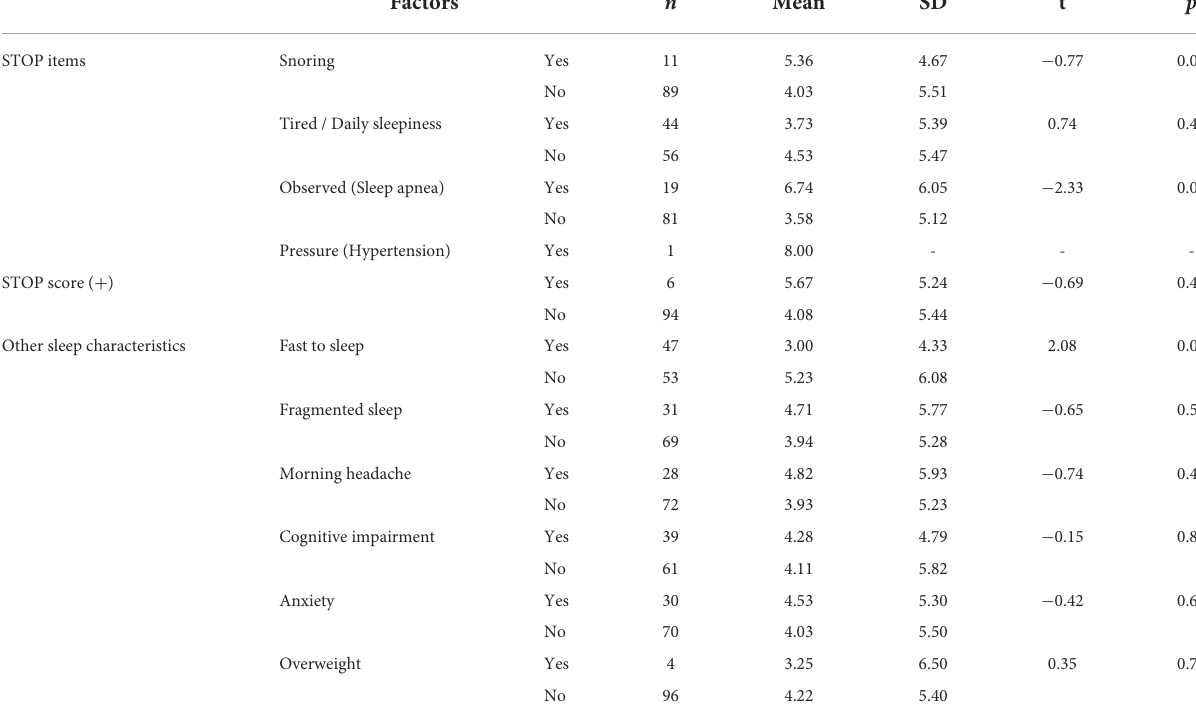
TABLE 3 Sleep characteristics and Pichot’s Fatigue score of study participants ( n = 100). Factors n Mean SD t